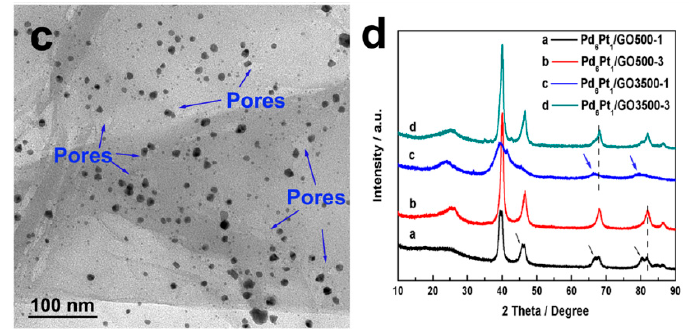
Figure 2. TEM images of the ( a ) Pd 6 Pt 1 / rGO500-3; ( b ) Pd 6 Pt 1 / rGO3500-1; and ( c ) Pd 6 Pt 1 / rGO3500-3 electrocatalysts; ( d ) XRD patterns of the Pd 6 Pt 1 / rGO500-1, Pd 6 Pt 1 / rGO500-3, Pd 6 Pt 1 / rGO3500-1, and Pd 6 Pt 1 / rGO3500-3 electrocatalysts.